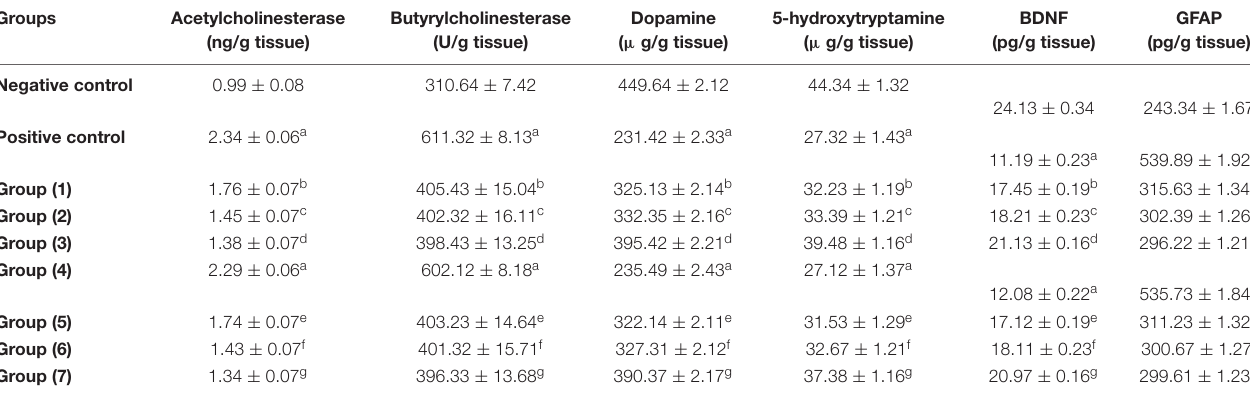
TABLE 6 | Effects of the RB, BR, and SL complex coacervates and UF cheese with these complex coacervates on biochemical parameters. Groups